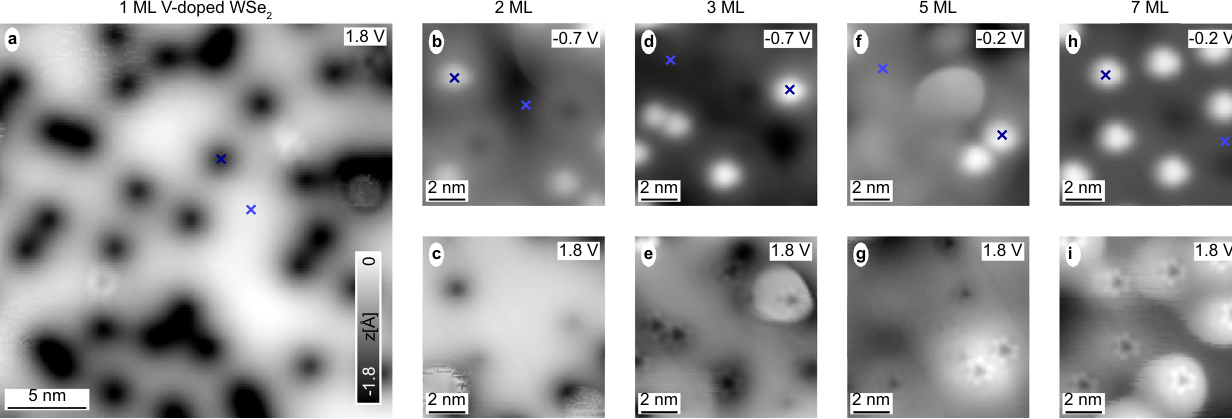
Fig. 3 Layer-dependent appearance of vanadium dopants. a – i STM images of 1 ML ( a ), 2 ML ( b , c ), 3 ML ( d , e ), 5 ML ( f , g ), and 7 ML ( h , i ) V-doped WSe 2 . The blue markers indicate the positions at which the d I /d V spectra shown in Fig. 4a, b have been recorded. V B is indicated in the top right corner in each STM